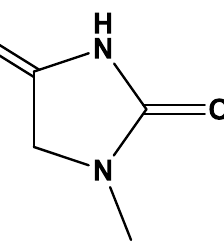
Figure 1. Molecular structure of 1-methylhydantoin (1MH).